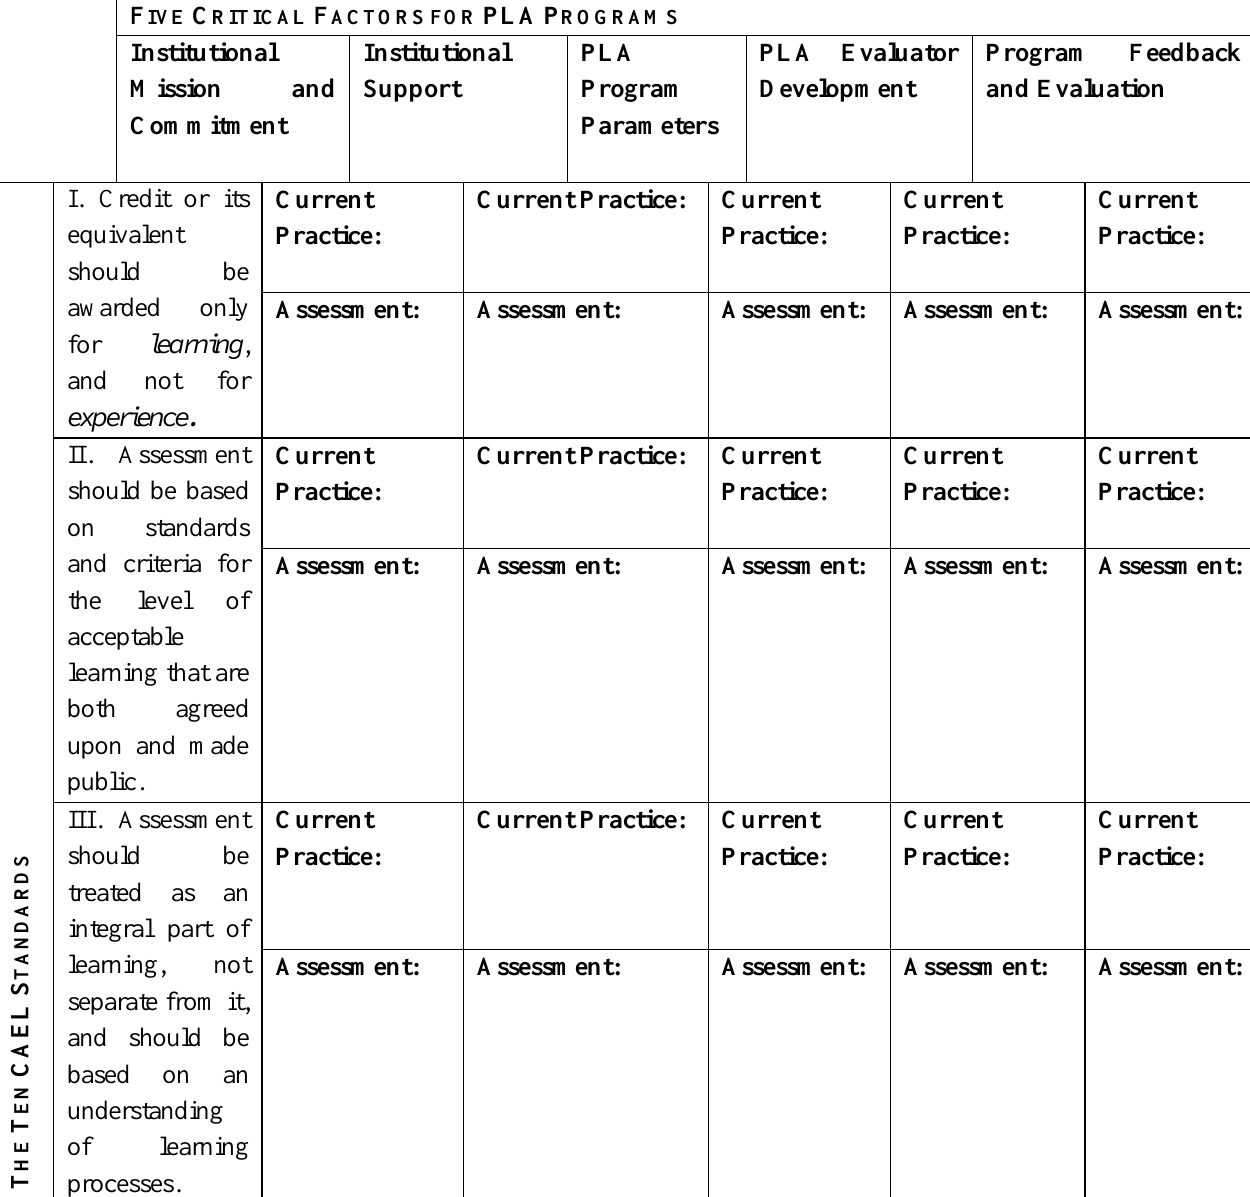
Table 1: Ten-by-Five Matrix Framework for Prior Learning Assessment Programs F IVE C RITICAL F ACTORS FOR PLA P